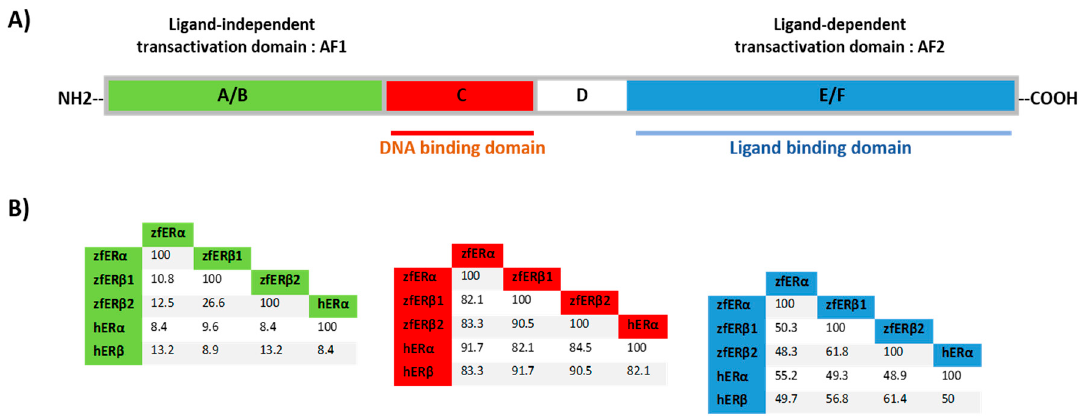
Figure 3. Schematic ER structure and the percentage identity between human ER (hER) and zebrafish ER (zfER) forms. ( A ) Different domains involved in DNA binding, ligand binding, and ligand-independent transactivation function (AF-1) and ligand-dependent transactivation function (AF-2) are indicated; ( B ) the percentage identity of coding regions of the N-terminal, DNA binding, and ligand binding domains between zfER α , zfER β 1, zfER β 2, hER α and hER β , are indicated